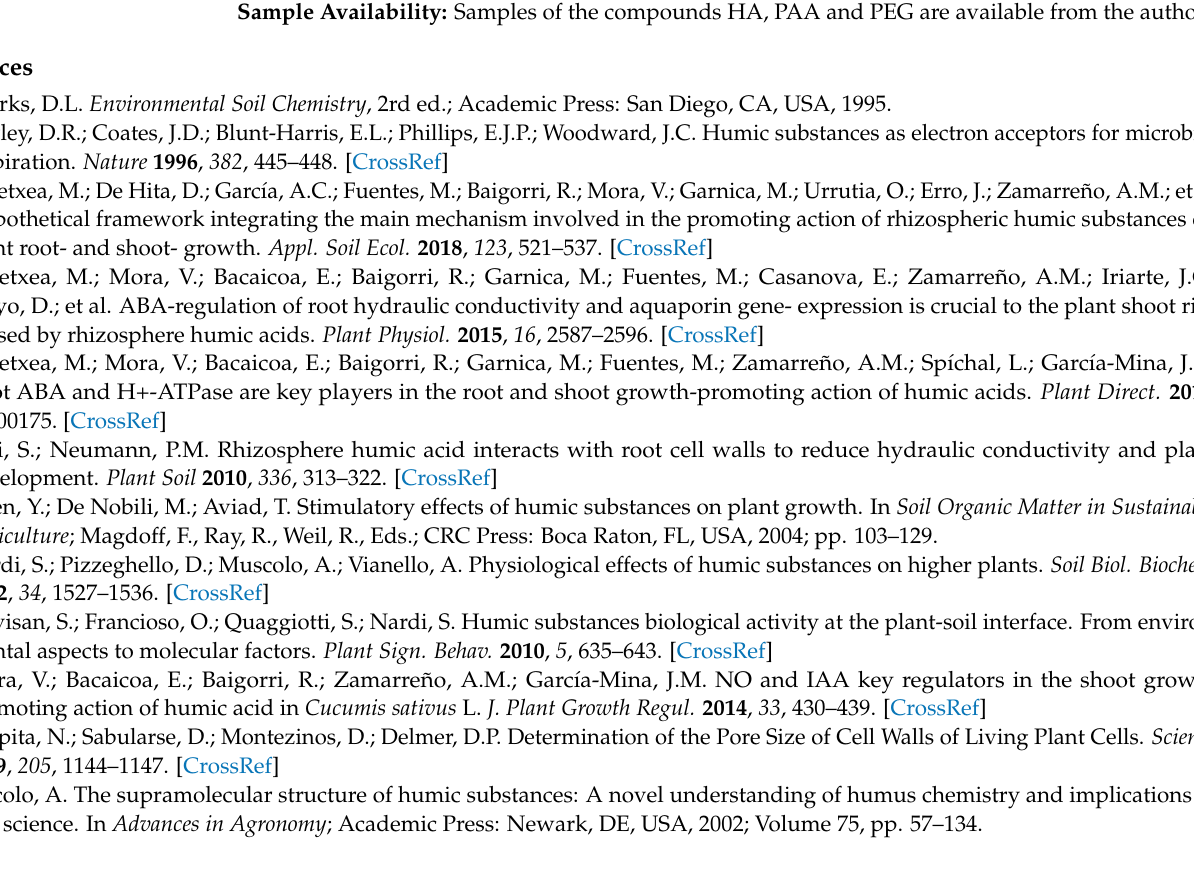
Figure S4: Lpr ± standard error ( n = 5). Time evolution of Lpr for the treated